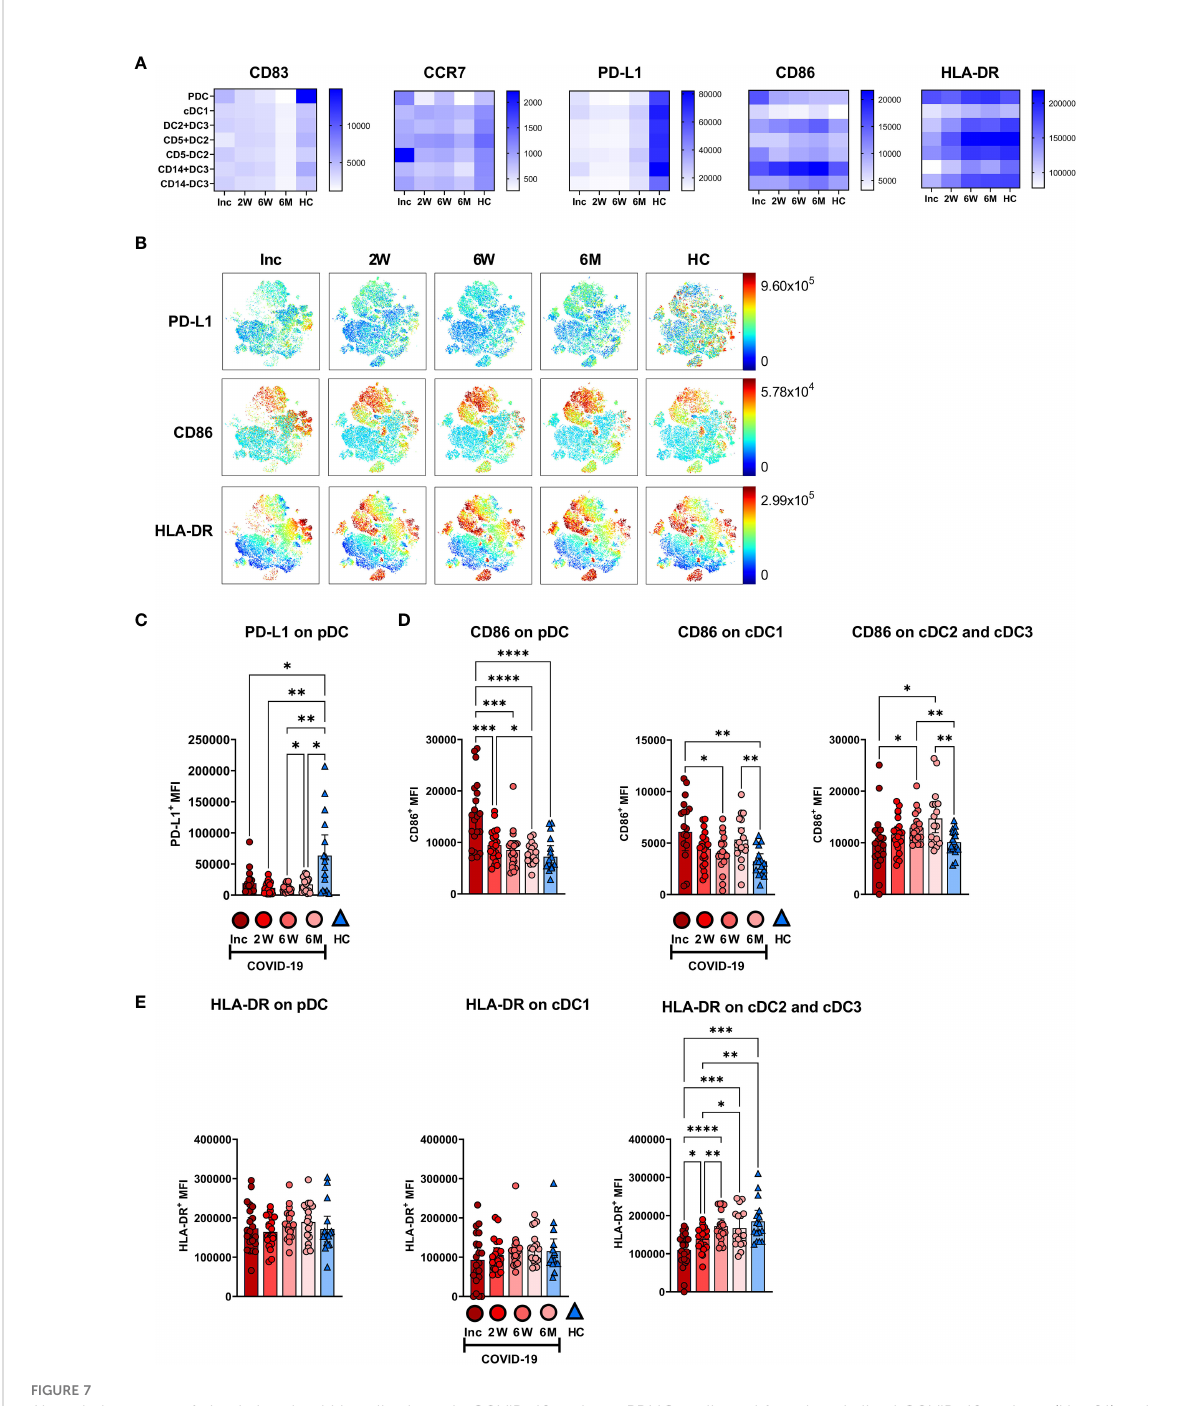
FIGURE 7 Altered phenotype of circulating dendritic cell subsets in COVID-19 patients. PBMCs collected from hospitalized COVID-19 patients (N = 21) and healthy controls (N = 16) over a 6 − 7 months period, were assessed for phenotypical changes. (A) Heatmaps showing the mean fl uorescence intensity (MFI) of CD83, CCR7, PD-L1, CD86, and HLA-DR on different DC subsets. (B) tSNE plots showing CD88 - myeloid cells, colored according to intensity of PD-L1, CD86, and HLA-DR expression. (C) Representative graph of PD-L1 on pDC. MFI of (D) CD86 and (E) HLA-DR on DC subsets. Data is represented as mean with 95% Cl, with signi fi cance of *p ≤ 0.05, **p ≤ 0.01, ***p ≤ 0.001, ****p ≤ 0.0001., determined using Brown- Forsythe and Welch ANOVA tests. Inc, Study inclusion; 2W, 2 weeks; 6W, 6 weeks; 6M, 6-7 months; HC, healthy